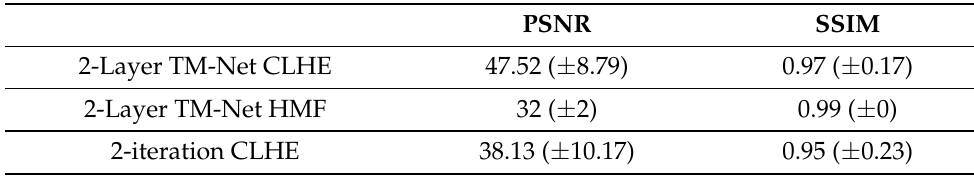
Figure 10. For each image in the set: First, original image. Middle, image enhanced with CLHE . Right, image enhanced with a 2-layer TM-Net. Mean of mean ∆ E between the enhanced images are shown in top right of each image. Table 3. Mean ( ± standard deviation) PSNR and SSIM statistics for both networks using the Chal- lenging Images